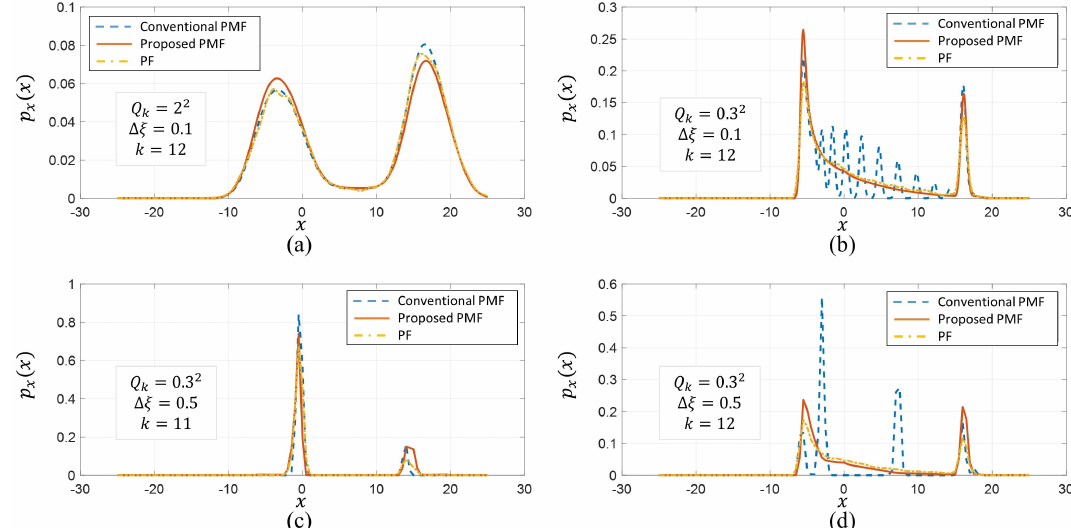
Figure 3. Comparison of the estimated PDFs between the conventional PMF, the proposed PMF, and the PF for several different cases ( a ) Q k = 2 2 , ∆ ξ = 0.1, k = 12 ( b ) Q k = 0.3 2 , ∆ ξ = 0.1, k = 12 ( c ) Q k = 0.3 2 , ∆ ξ = 0.0.5, k = 11 ( d ) Q k = 0.3 2 , ∆ ξ = 0.0.5, k =